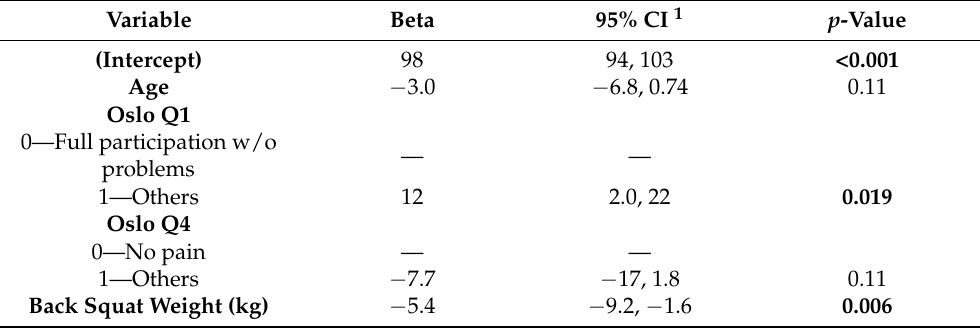
Table 3. Multiple Regression Analysis for the Relationship Between Variables and Back-PAQ Scores.